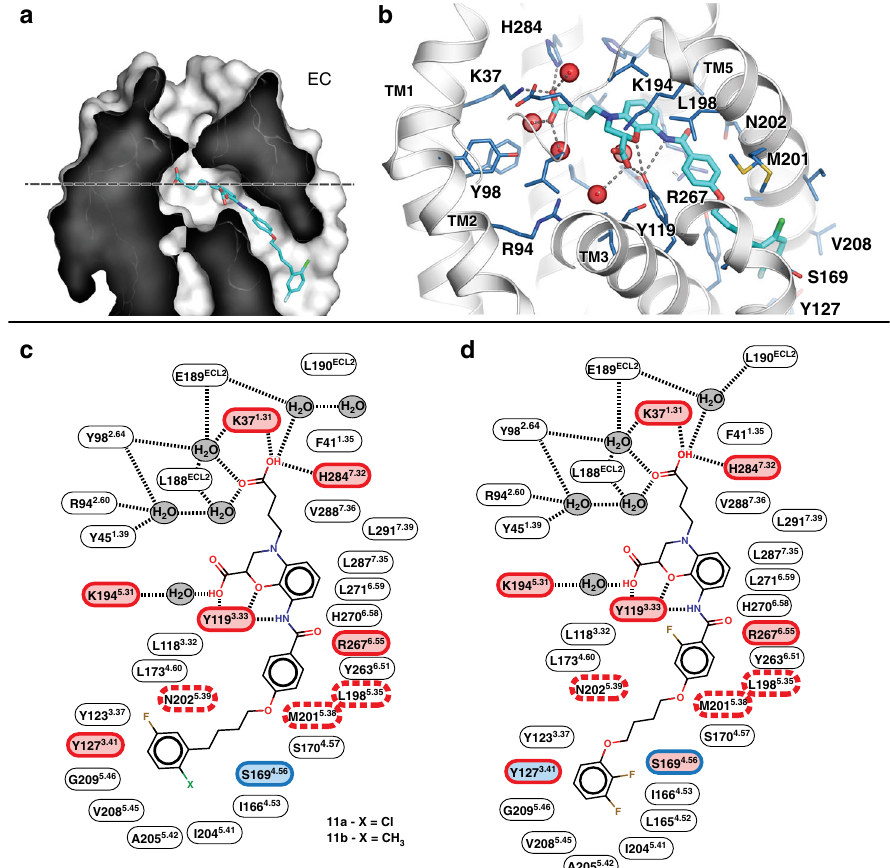
Fig. 2 Ligand-binding pocket of CysLT 2 R. a Sliced surface representation of the ligand-binding pocket in CysLT 2 R. b Binding pose of cpd 11a and details of ligand-receptor interactions. Schematic diagrams of CysLT 2 R interactions with cpds 11a and 11b ( c ) and cpd 11c ( d ). Residues are colored according to the effect of their mutations on the antagonist potency in IP 1 signaling assays: light red — strong effect, blue — no effect, white — not tested. The outline color indicates the effect of mutations on LTD 4 potency: red — strong effect, red dashed — nonresponsive mutants, blue — no